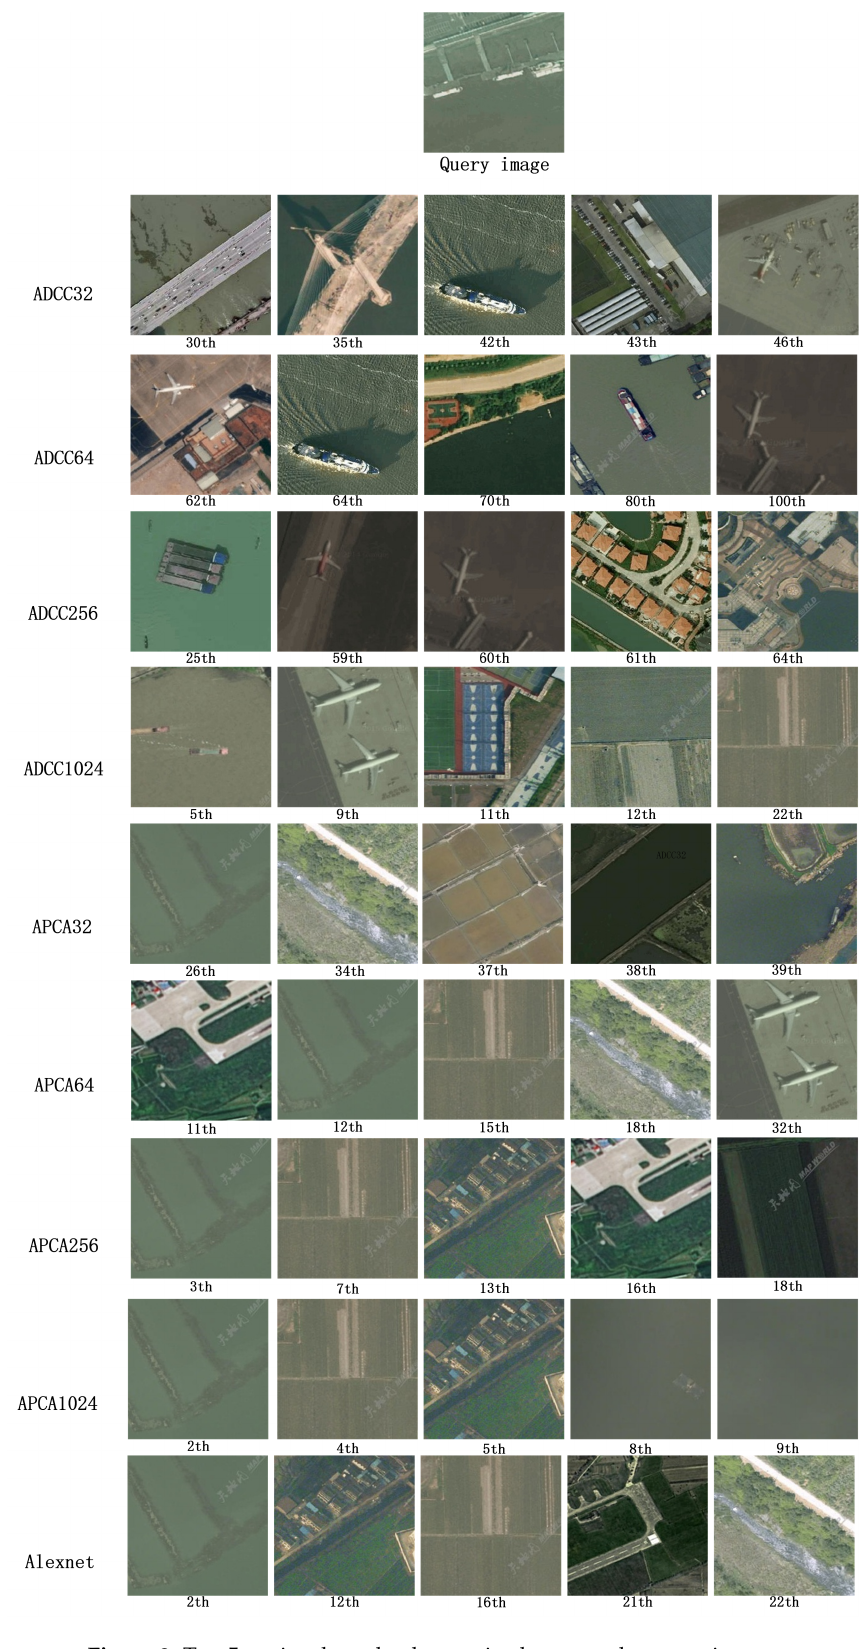
Figure 3. Top-5 retrieval results that are irrelevant to the query